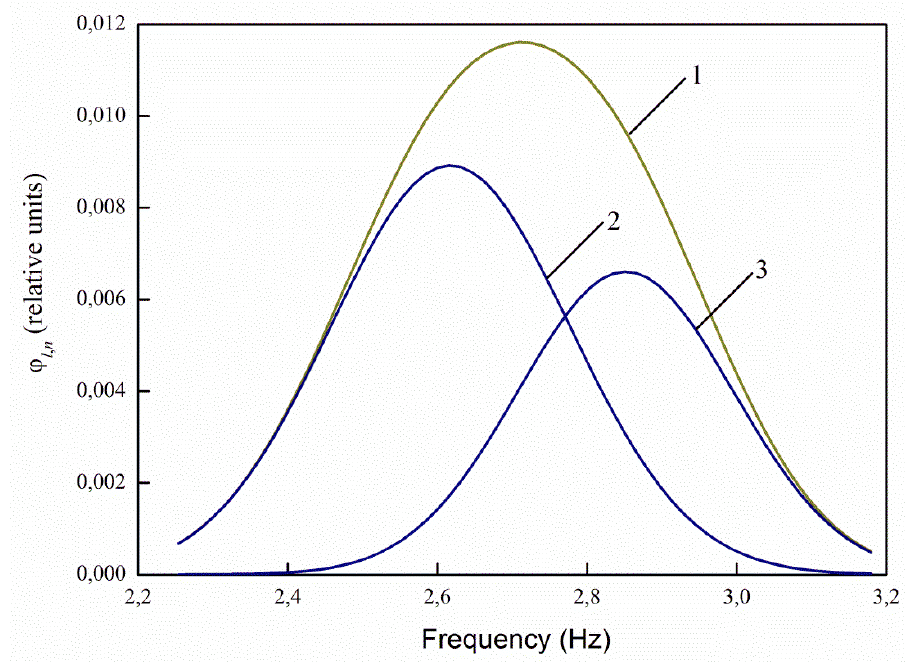
Figure 9. The spectral characteristic of the luminescence of uninfected replacements of wheat at λ e, 2 = 362 nm (1), decomposition by Gaussian curves (2) and (3).